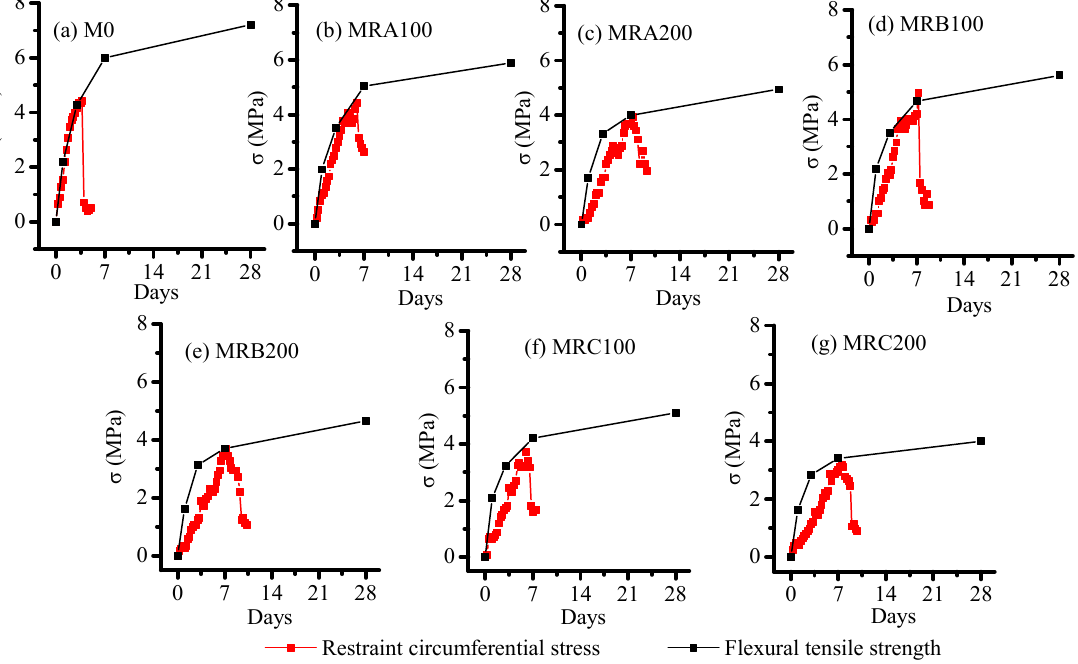
Figure 11. Comparison of restraint circumferential stress and flexural tensile Figure 11 Comparison of restraint circumferential stress and flexural tensile strength.